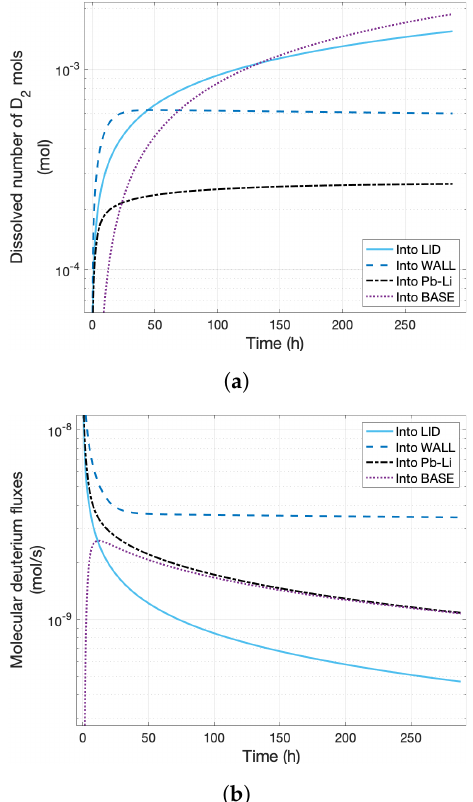
Figure 12. Evolution of number of moles dissolved in, and fluxes through, each UC part for a simulation of 288h, using avg dissolution parameters ( vide Tables 1 and 3). Values given in molecular amounts, instead of atomic, for easier comparison with the amount of gas injected in the chamber. Initial gas pressure set to 780 mbar and BASE temperature set to 450 ◦ C. ( a ) Evolution of the equivalent molecular number of moles of deuterium dissolved, in logarithmic scale. ( b ) Evolution of the equivalent molecular fluxes of deuterium, in logarithmic scale. Fluxes into Pb-Li and into BASE tend to the same value as the system tends to an equilibrium